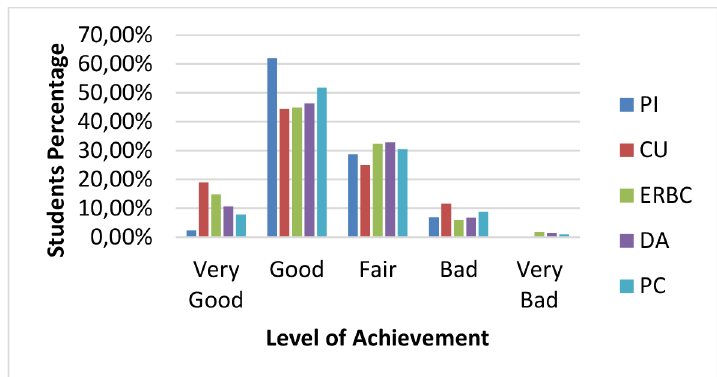
Figure 5. Histogram of Each Indicator of Critical Thinking Skills Level